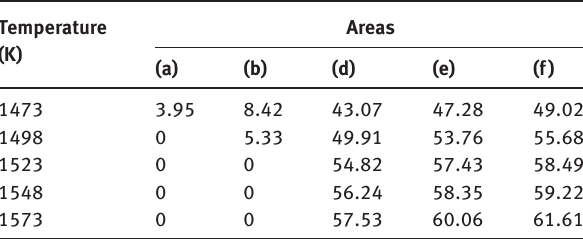
Table 4: Variations of volume fraction of V-containing spinel phase in different areas of the samples with different temperature at G = 1050, t = 30 min Temperature Areas